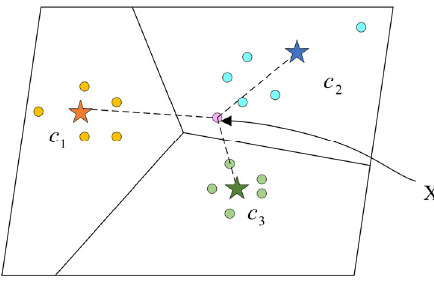
c , while its distance with class 2 , while its distance with class c 3 is 2